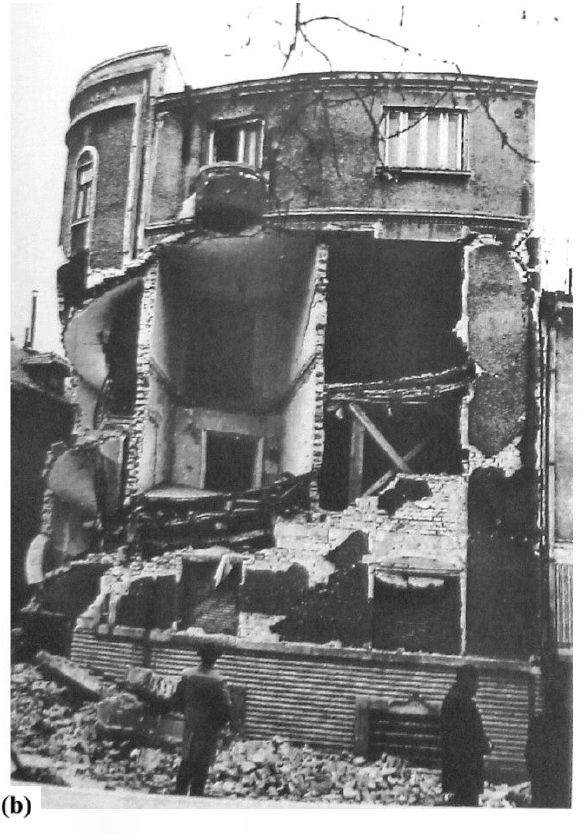
Figure 8. Partial collapse of buildings. (a) The Wilson building (reinforced concrete frame building with masonry infill walls). (b) A masonry building. (photos by Hirosawa